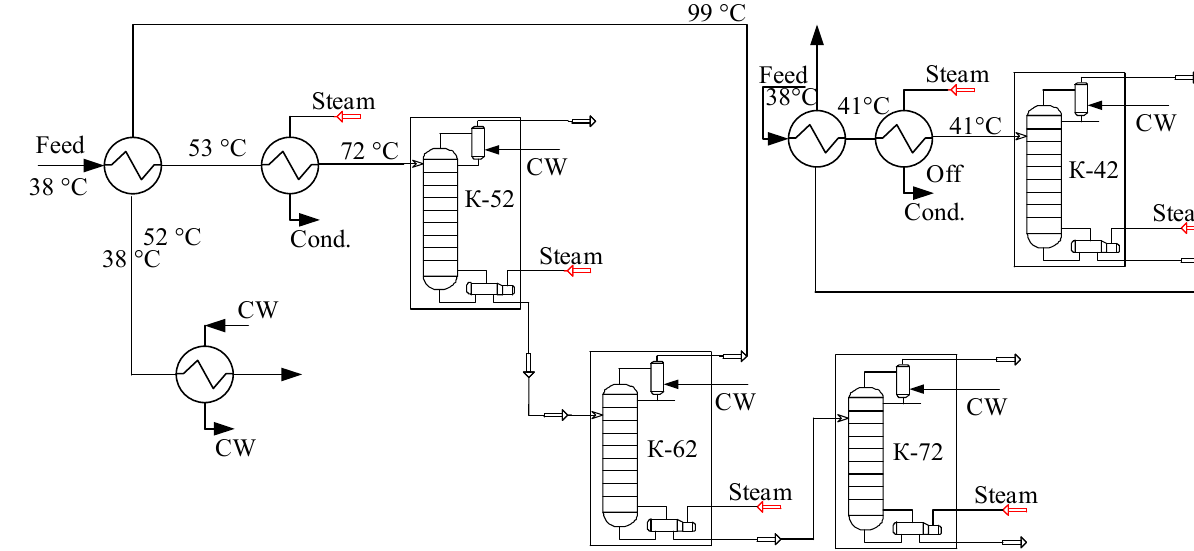
Figure 2. Schematic diagram of the unit for the production of ethylbenzene. K—distillation column; CW—cooling water.